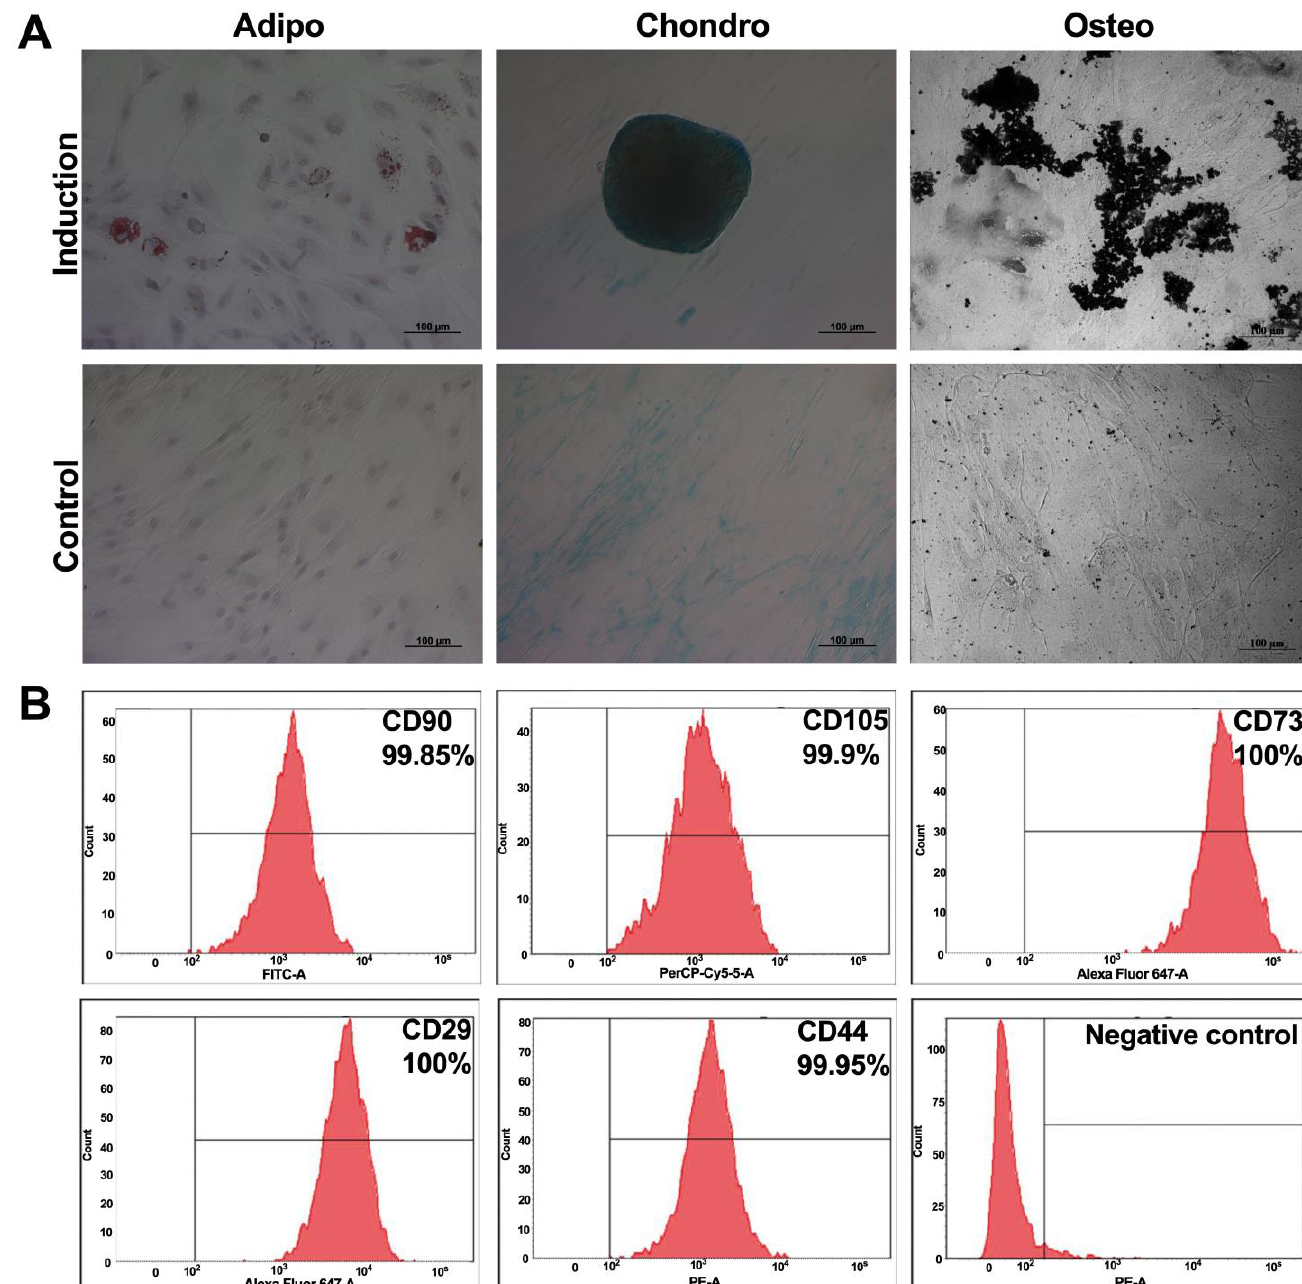
Figure 2. Characteristics of MSCs. ( A ) Directed differentiation of isolated MSCs into adipogenic, chondrogenic and osteogenic directions. Scale: 100 µm. ( B ) Immunophenotypic characteristics of MSCs isolated from human adipose tissue. The graphs represent the percentage of positive cells. Negative control − a mixture of hematopoietic cell markers (CD11b, CD19, CD34, CD45, HLA-DR and CD45). Data are shown as the mean ± SD ( n = 6) of two biological replicates.